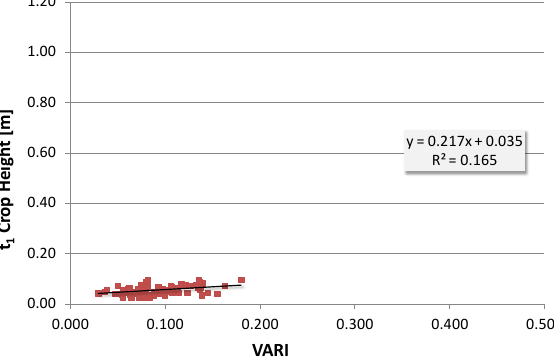
deficiency symptoms. Potassium deficiency results in